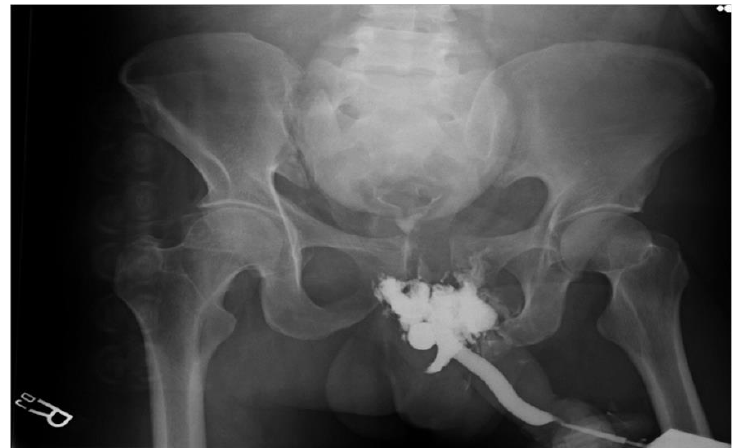
Figure 2. RUG indicating urethral